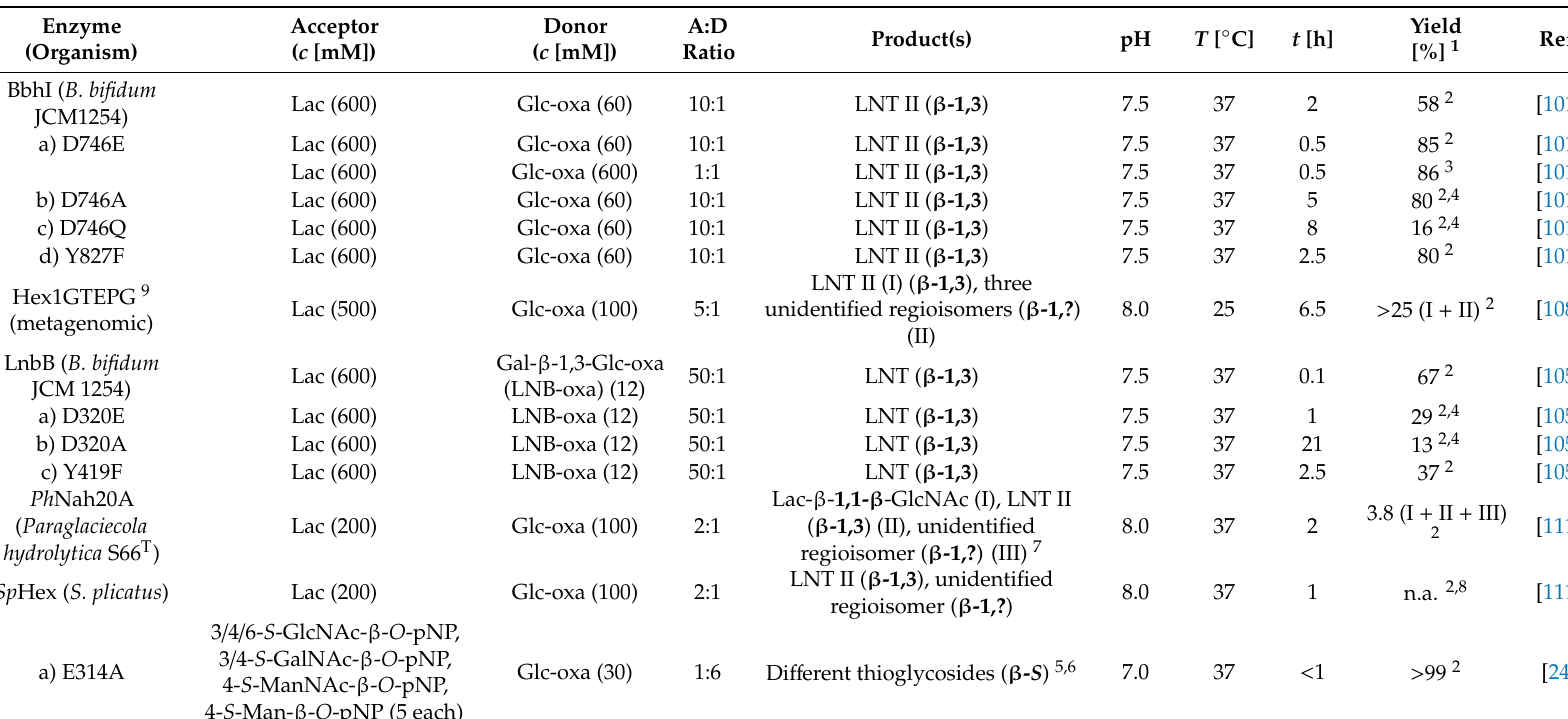
Table 9. Trans-glycosylation reactions catalyzed by GH20 enzymes using oxazoline-activated carbohydrate donor substrates. New bonds are highlighted in bold. Enzyme (Organism) BbhI ( B.